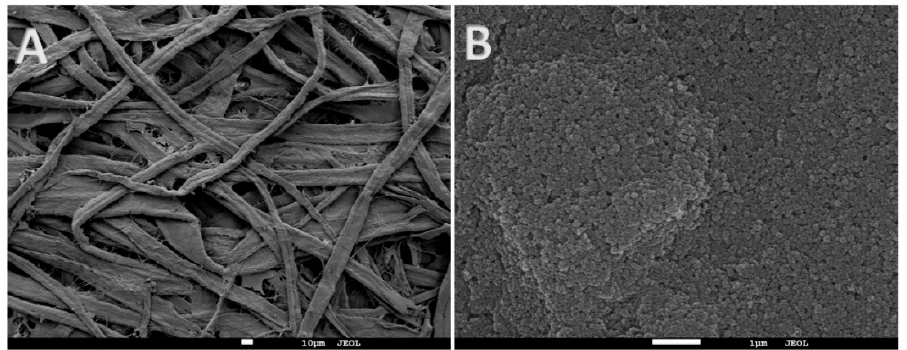
Figure 3. SEM images obtained for ( A ) a bare paper and ( B ) a paper modified with suprastructures of carbon nanohorns. Reprinted from [117].